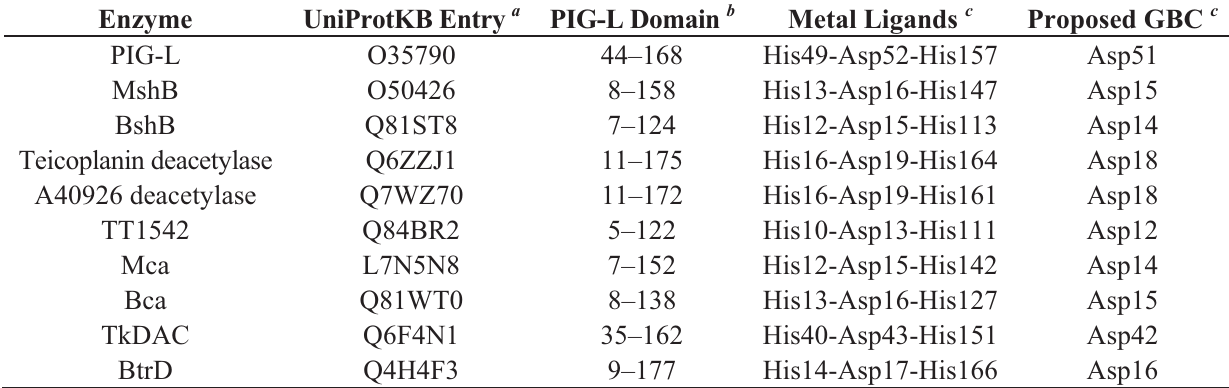
Table 1. LmbE-like enzyme conserved PIG-L domains and catalytically important side chains.